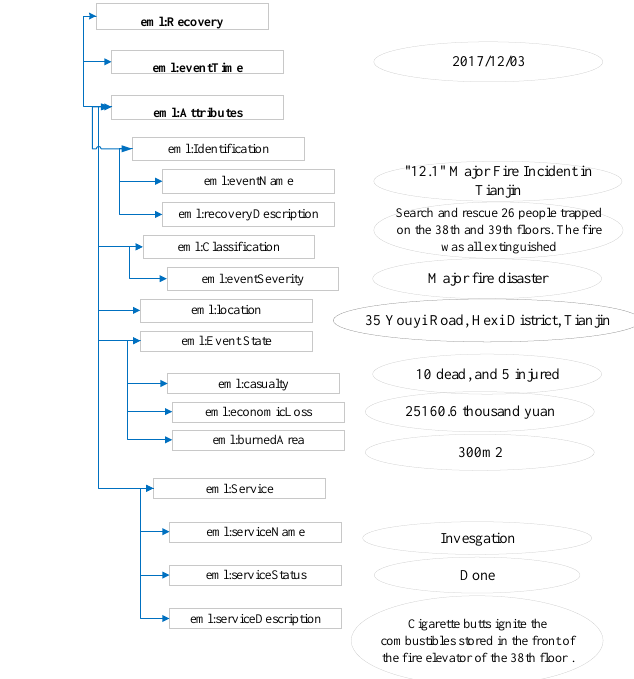
Figure 6. Mitigation and preparedness phase modelling result